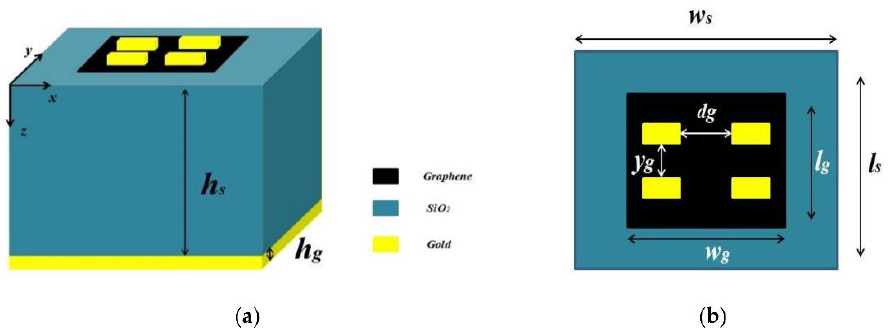
Figure 7. Absorber unit cell structure is depicted with a single sheet of graphene and four small sized gold bars. ( a ) 3D view: the absorber consists of a gold meta-array at the top. Gold bars with height hg and width w are placed in the form of a 2 × 2 array. Beneath the gold bars and above the substrate is a graphene layer growing on a silicon dioxide (SiO 2 ) substrate with thickness h s and ε r = 2.25. To reduce the transmission, an additional gold layer with thickness hg is used. ( b ) 2D top view. Reprinted from [92].